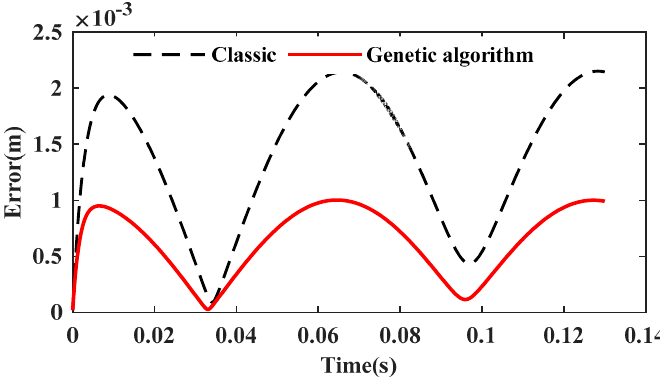
Figure 10. The errors of using the classic PID and the PID optimized by a genetic algorithm in the presence of disturbances.